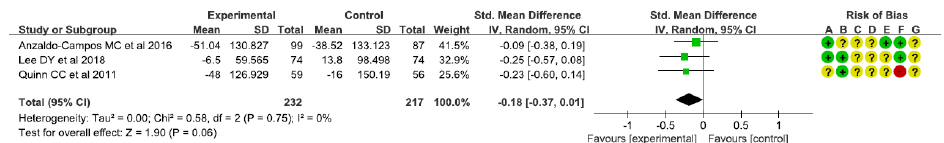
Figure 6. Forest plot for meta-analysis results on total cholesterol [10,15,16].